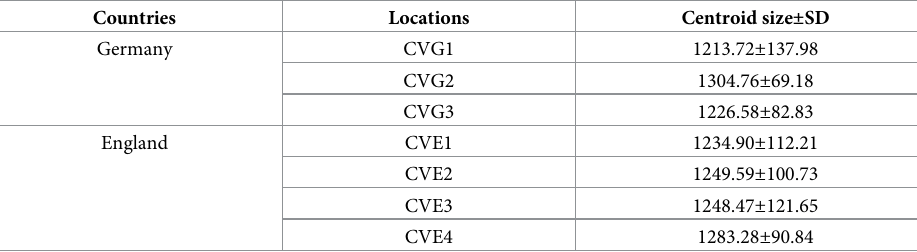
Table 3. Centroid size ± SD of C . vicina in 7 sampling